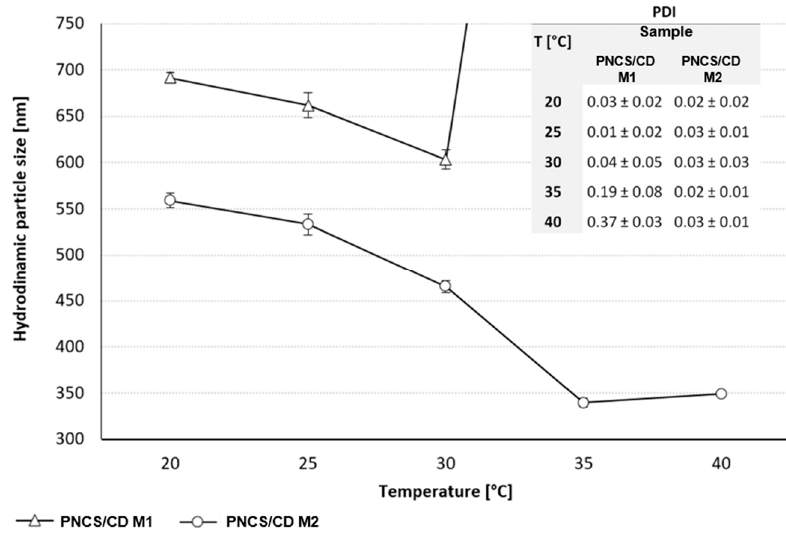
Figure 3. Hydrodynamic PNCS/CD hydrogels particle diameter in the dispersion with the corresponding polydispersity index (PDI) values.